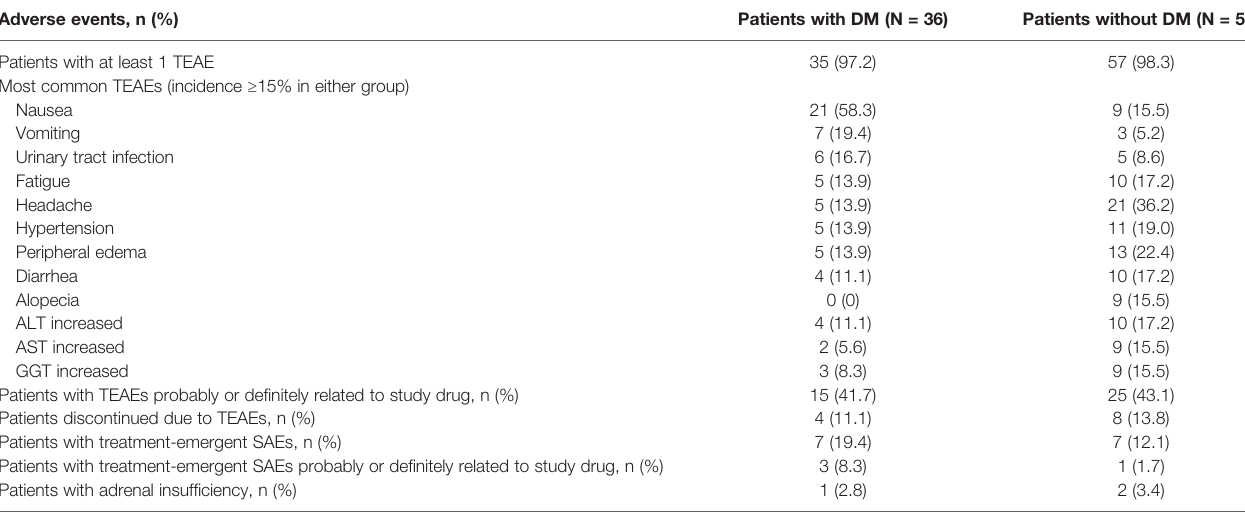
TABLE 5 | Adverse events during the dose titration and maintenance phases (ITT population). Adverse events, n (%) Patients with DM (N =